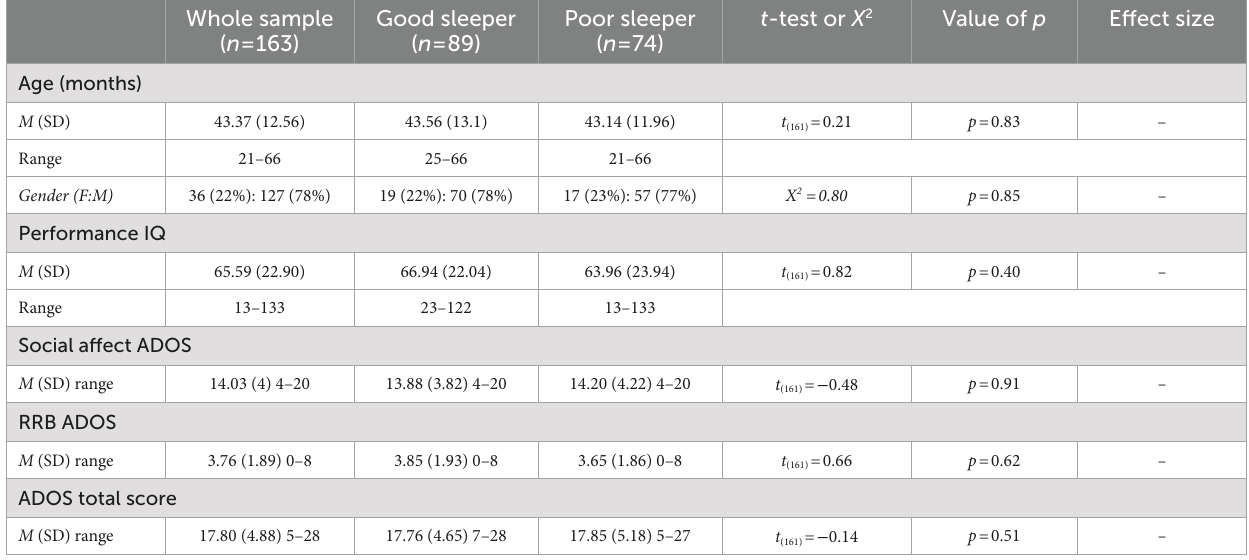
TABLE 1 Demographic, clinical characteristics in the total sample ( n = 163), and in each sleep group. Whole sample ( n =